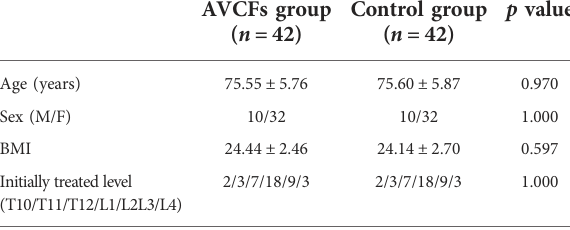
TABLE 1 Demographic and clinical characteristics of both